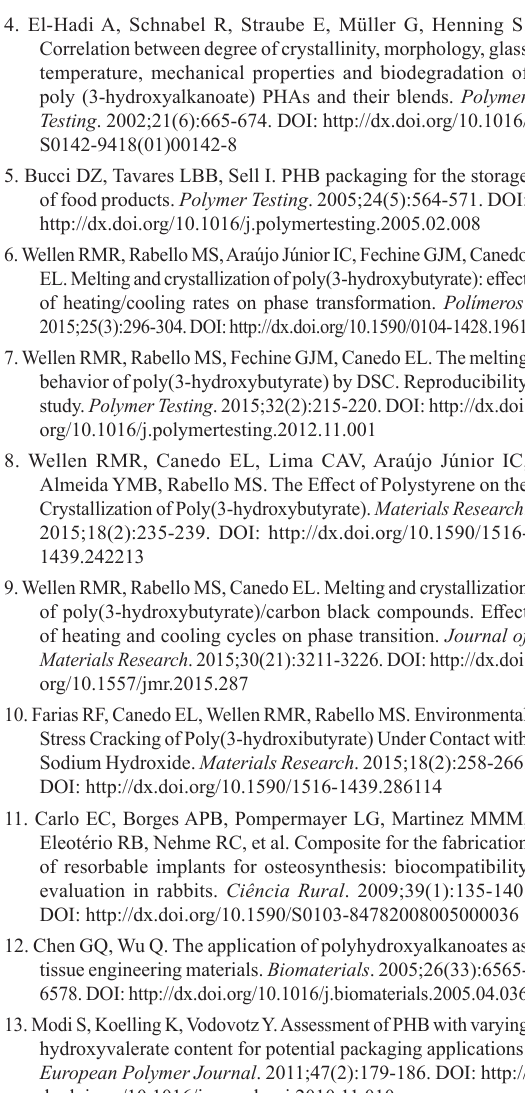
Table 3: Crystallinity degree (X Exposure time